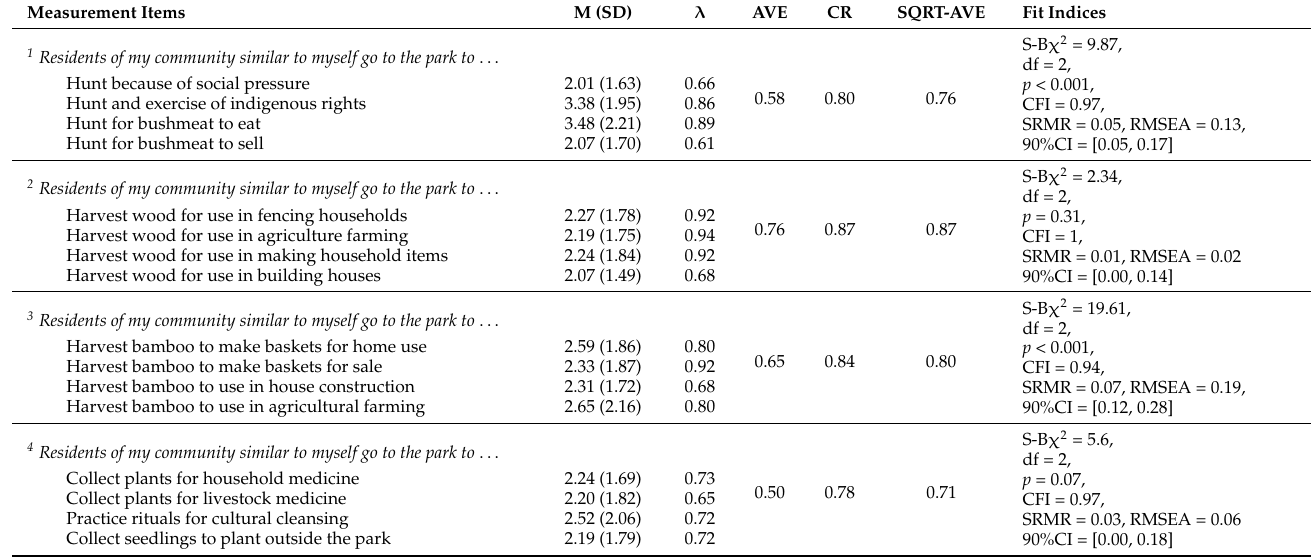
Table 2. Measurement Model Results for Illegal Activities